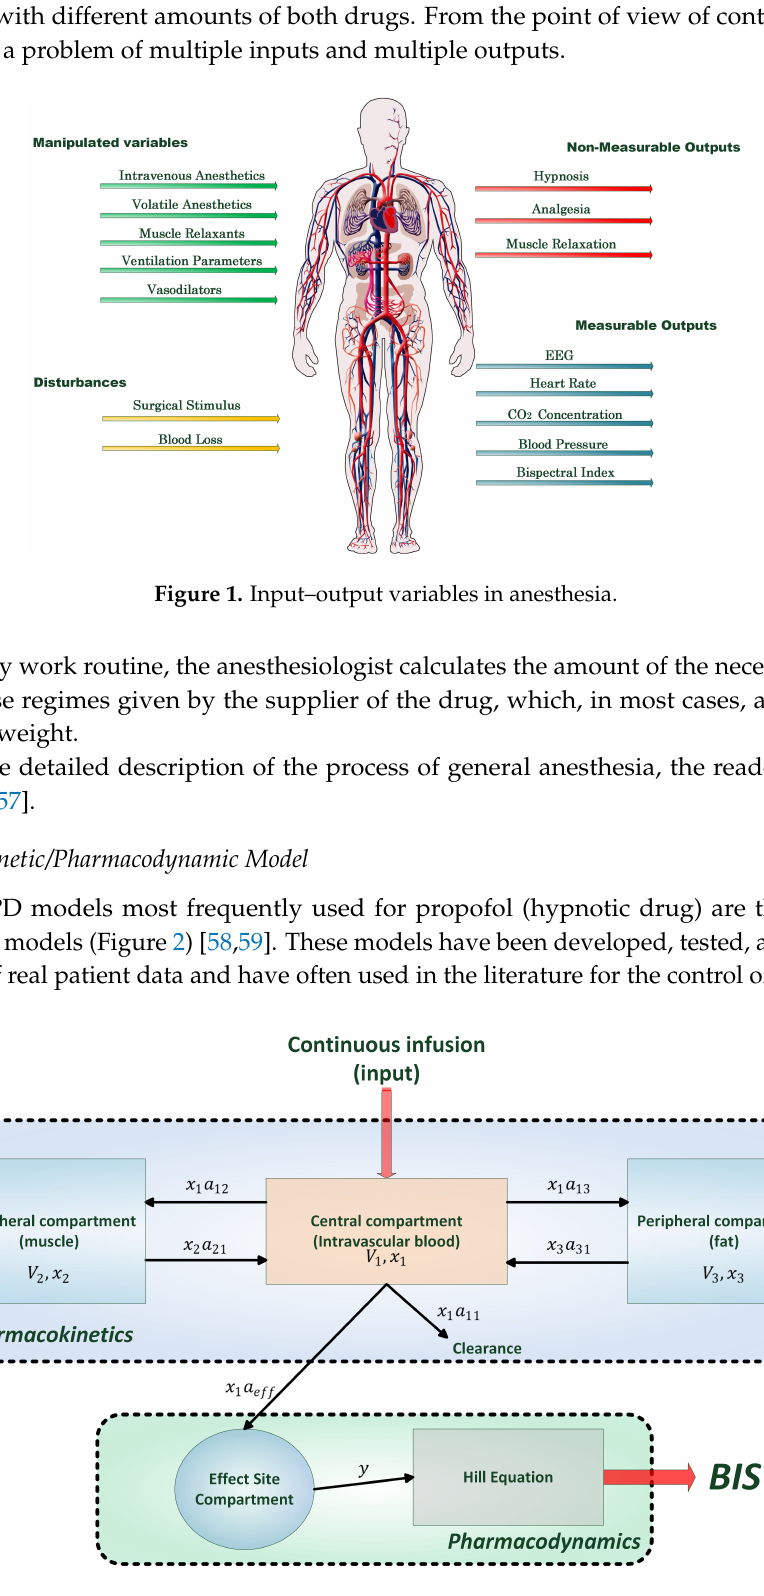
Figure 2. PK/PD (pharmacokinetic/pharmacodynamic)